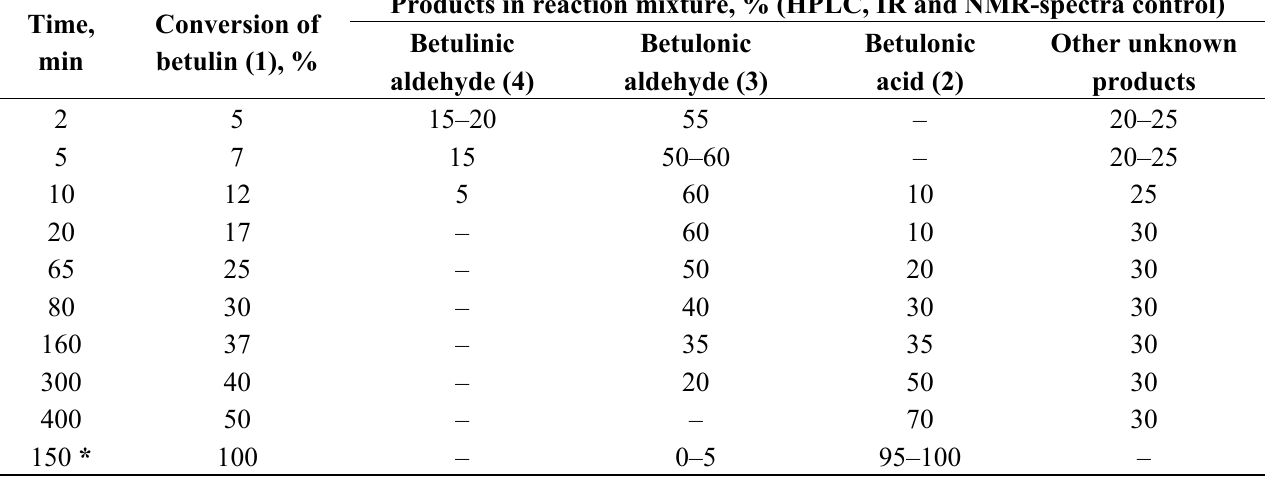
Table 1. Time distribution of selectivity in betulin oxidation without Al equal to 3 in acetone at room ratio ν Cr6+ / ν betulin